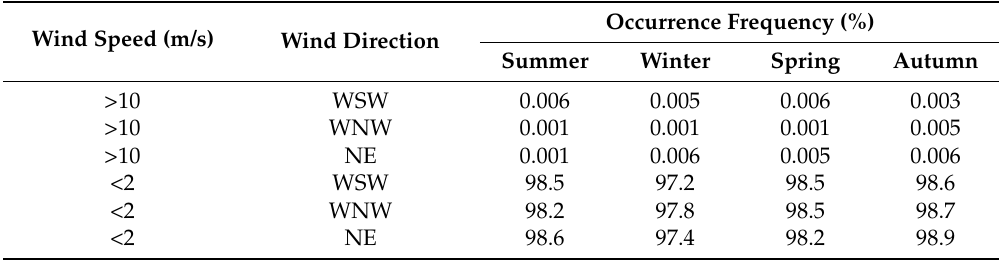
Table 3. Physical properties of Edremit–Zeytinli sea outfall.